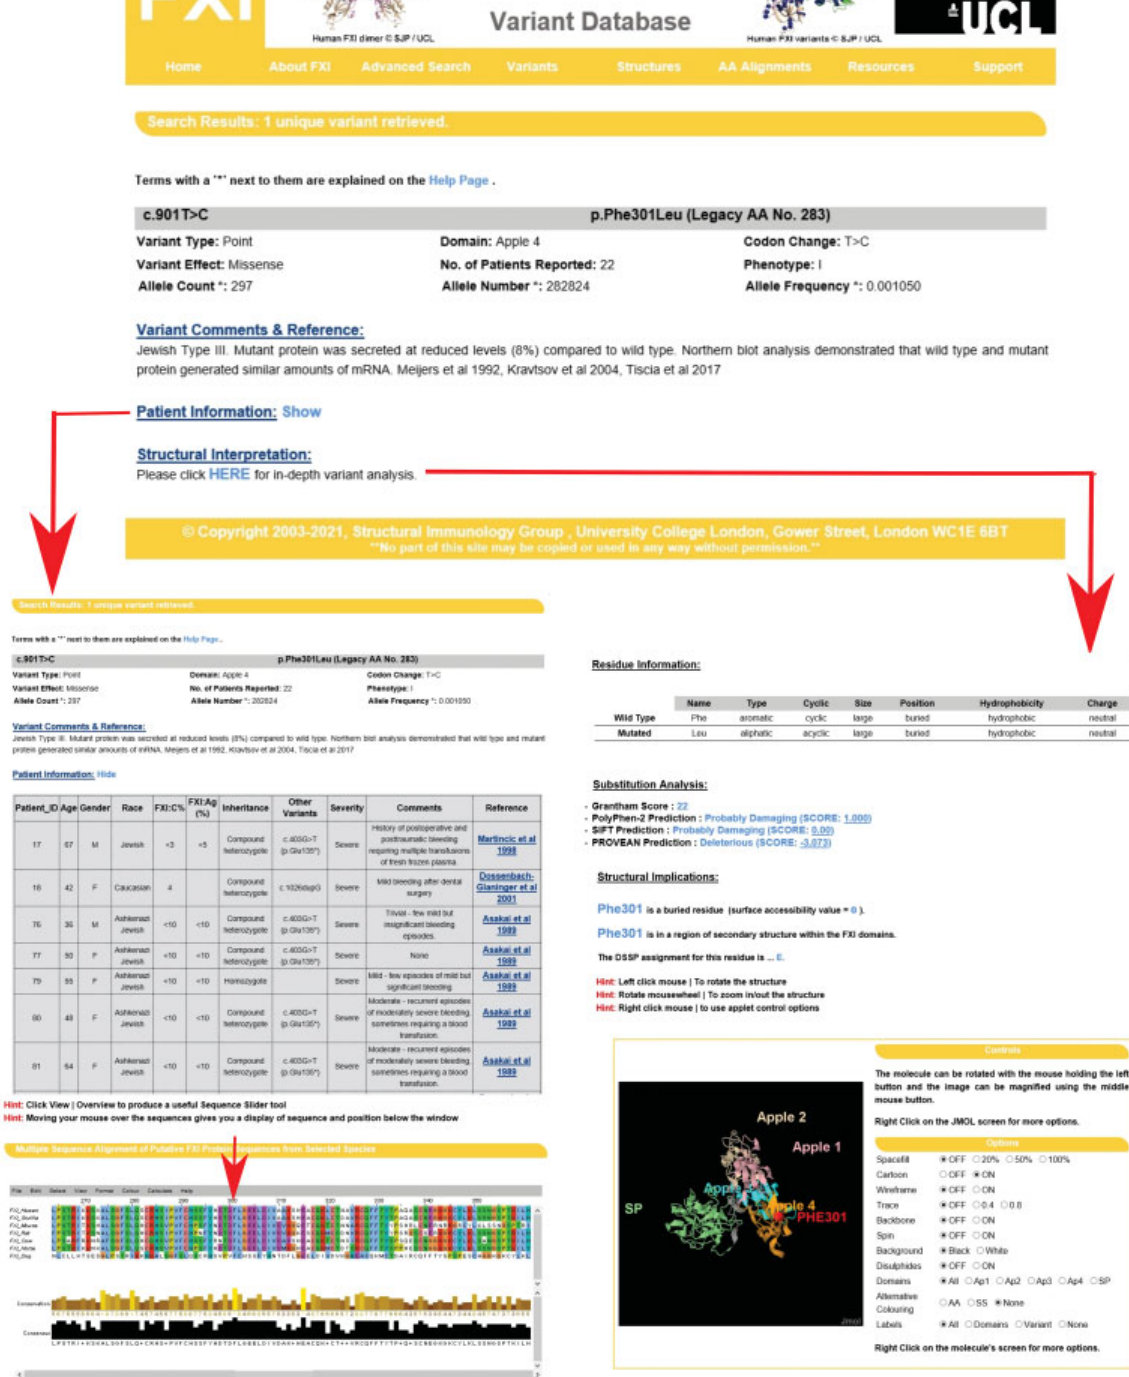
TH Open Vol. 5 No. 4/2021 © 2022. The